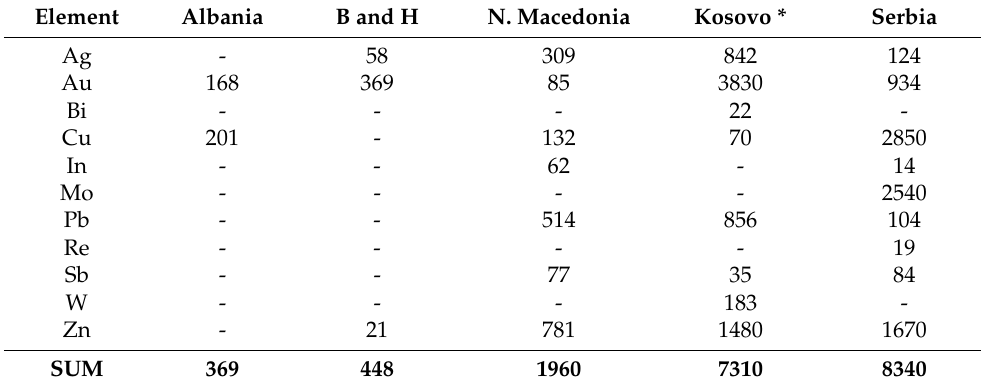
Table 5. Metal values per country (March 2022) in million